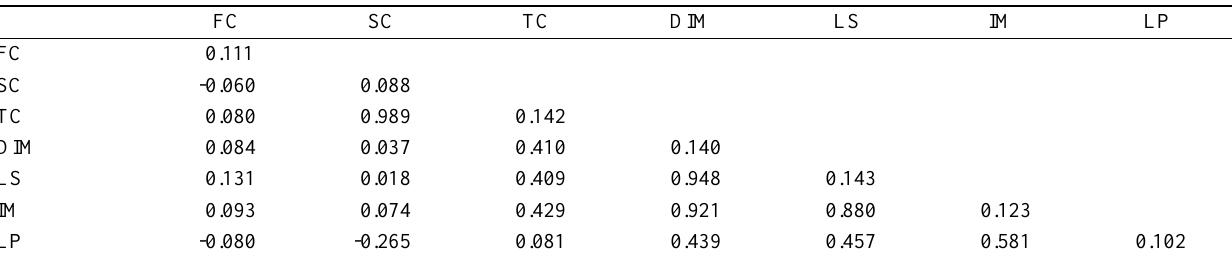
Table 3. Heritabilities and genetic correlations of reproductive traits and economic traits FC SC TC